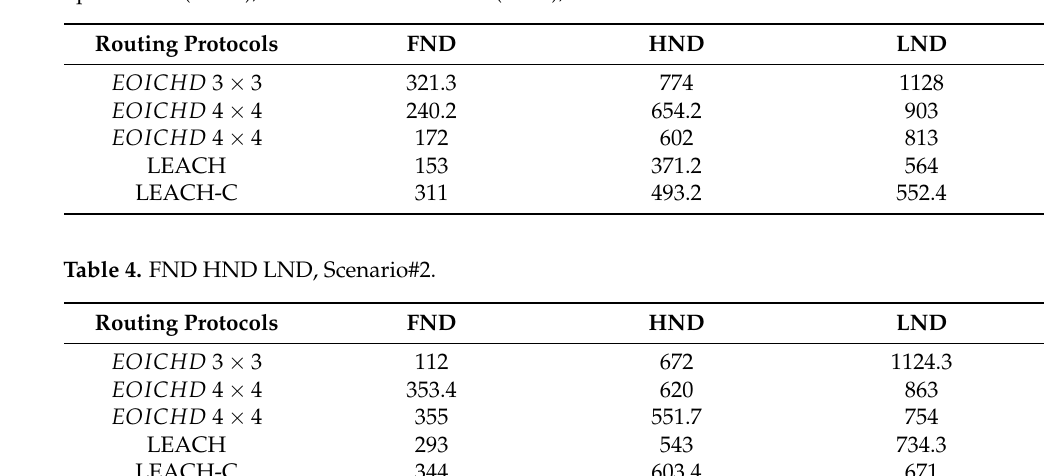
Table 3. First node that becomes dead (FND), half of the nodes of the network becoming non- operational (HND), and the last node dead (LND), Scenario #1.